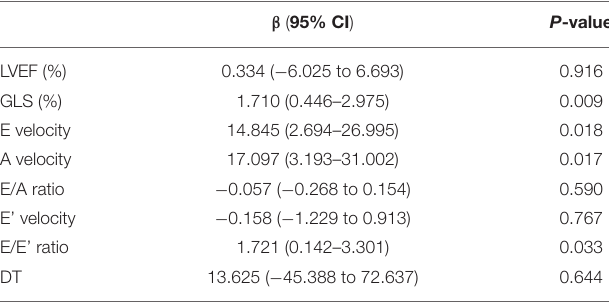
TABLE 2 | Multivariate linear regression analysis showing association between suPAR and echocardiographic parameters after adjusting for important covariates.